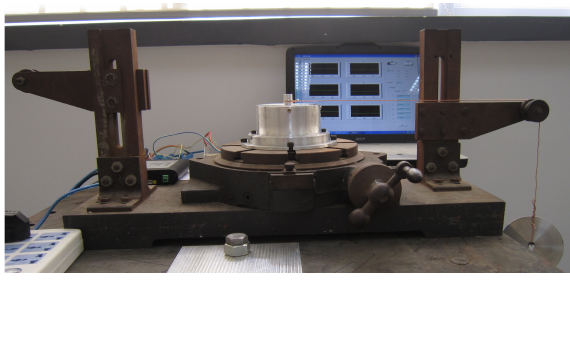
Figure 5. The static calibration experiment setup.